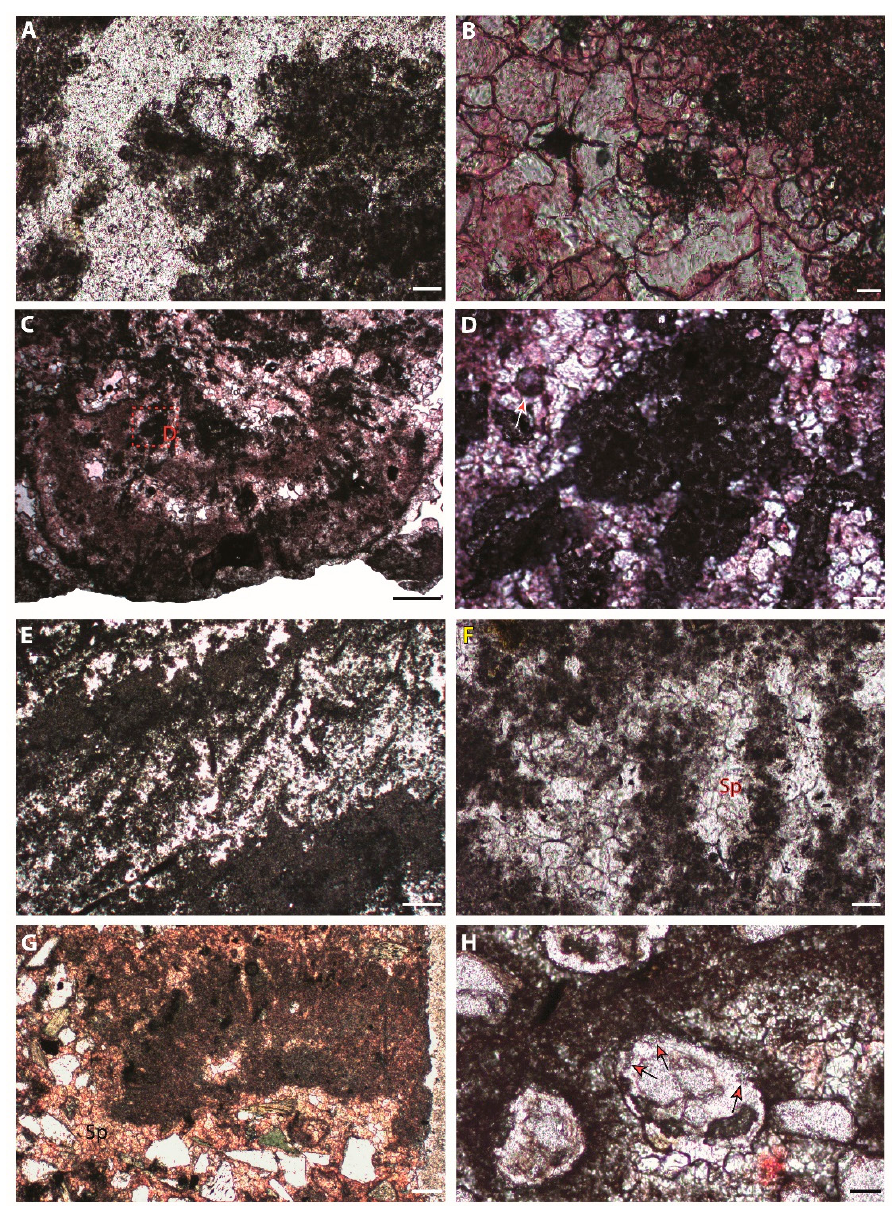
Figure 14. Examples of microbial microstructures found in TCC microbialites (see also Table 2 for a description). All the pictures correspond to polarizing microscope photographs in plane polarized light. ( A ) Dolomite peloids. Crinkle, Cariatiz, DS2. The scale bar is 50 µ m. ( B ) Close-up view of peloids encircled by microspar. The scale bar is 20 µ m. ( C ) Reniform structure including bushy peloid aggregates and di ff use micrite laminae. Thrombolitic crust, Cariatiz, DS4. The scale bar is 500 µ m. ( D ) Close-up view of ( C ), showing a downward branching, bushy peloid aggregate. The red arrow indicates a dolomite microsphere. The scale bar is 20 µ m. ( E ) Tepee peloidal structure. Branch, DS4, Las Negras. The scale bar is 500 µ m. ( F ) Close-up view of Figure 13G. Peloids are grouped into vertical micro-columns resulting from the mineralization of the sheath of filamentous cyanobacteria. Branch, DS4, Las Negras. The scale bar is 50 µ m. ( G ) Flabellate structure including some mineralized filaments, probably cyanobacteria. The original micrite was neomorphized into low magnesian calcite. Stacked hemispheroid, G ó char. The scale bar is 200 µ m. ( H ) Close-up view of a micritic laminae in an ooid-rich microbialite. Ooids (trapped?) are embedded in microbial micrite. Some show a bored rim (red arrows) imprinted in their partly dissolved cortex. These micro-borings could be related to the activity of endolithic bacteria. Small hemispheroid, DS4, Sorbas. The scale bar is 50 µ m.